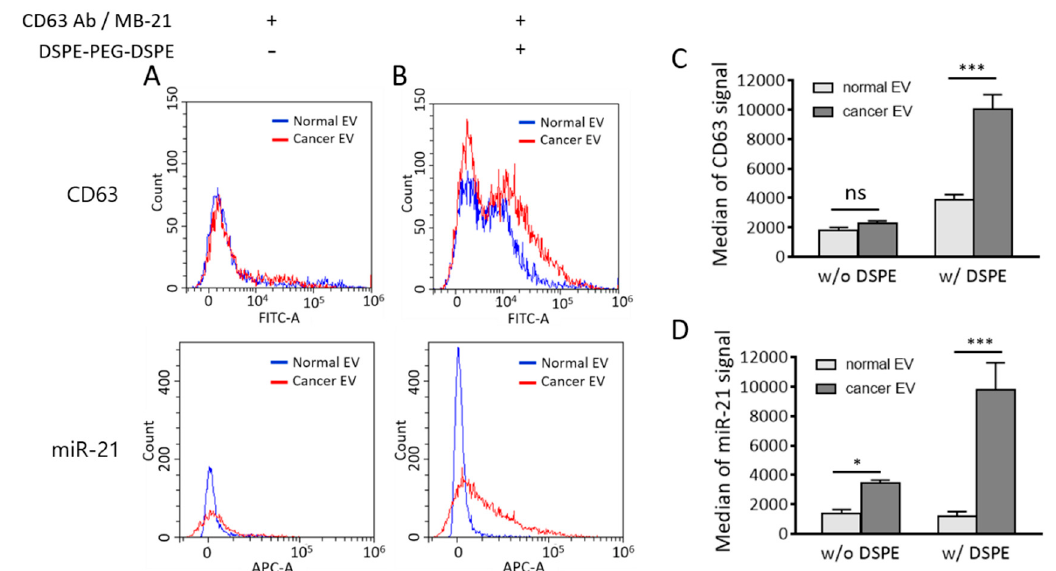
Figure 8. Comparison of flow cytometric results between normal and cancer EVs in the absence and presence of DSPE-PEG-DSPE. ( A , B ) Merged flow cytometric results of CD63 (upper) and miR-21 (lower) detection in normal and cancer EVs in the absence ( A ) and presence ( B ) of DSPE-PEG-DSPE. ( C , D ) Median fluorescence intensities of CD63 ( C ) and miR-21 ( D ) were calculated from flow cytometric results. All values are expressed as mean ± SD ( * p < 0.05, *** p < 0.001; ns: Not significant; n = 3).